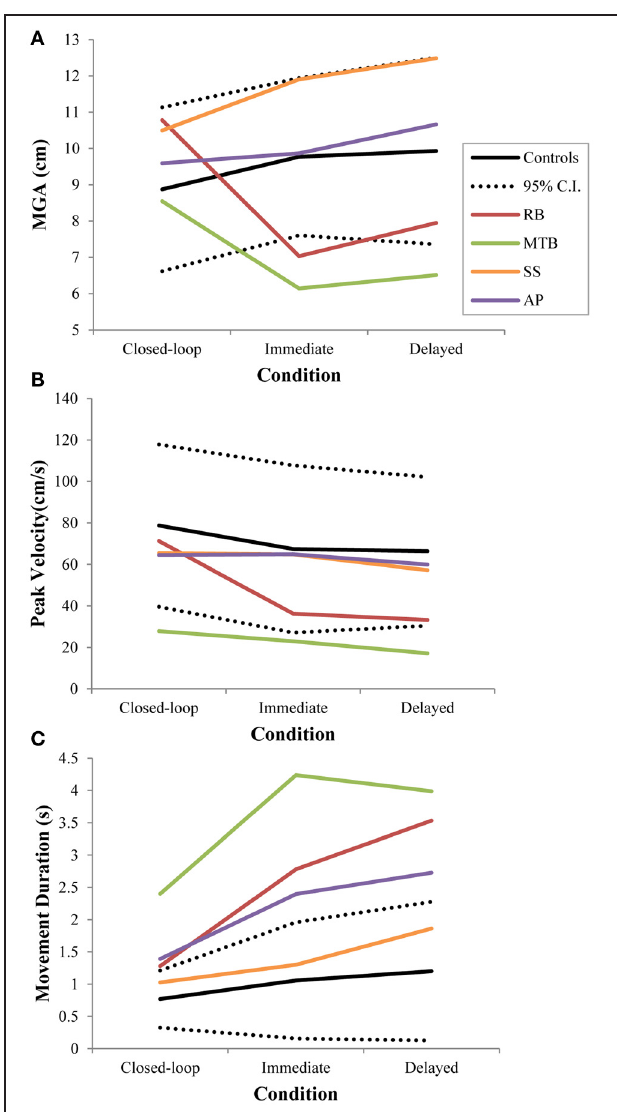
FIGURE 3 | Three different kinematic measures—(A): maximum grip aperture (MGA), (B): peak wrist velocity, and (C): movement duration—for patients and controls across all three conditions in Experiment 1. The dotted lines represent the upper and lower limits of the 95% confidence interval for control